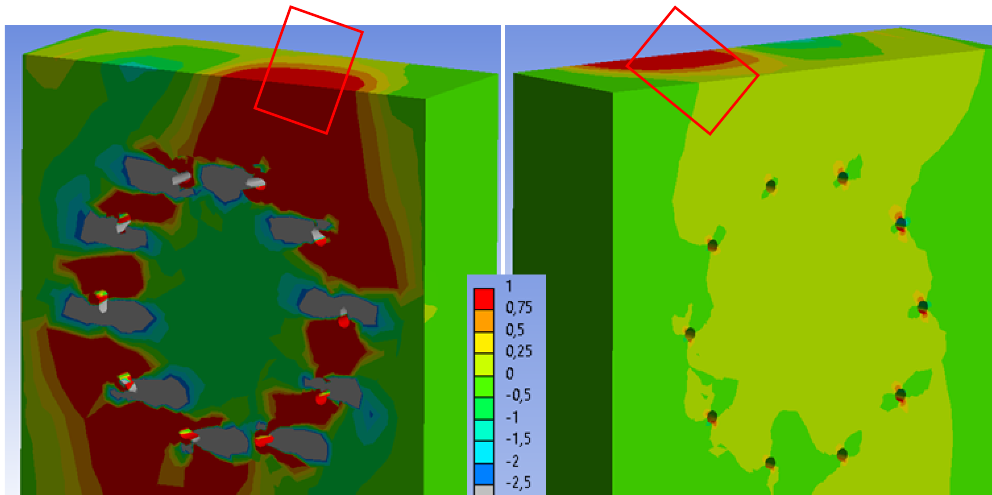
sile stress perpendicular to the grain from the numerical model (MPa) (on the ( right )).